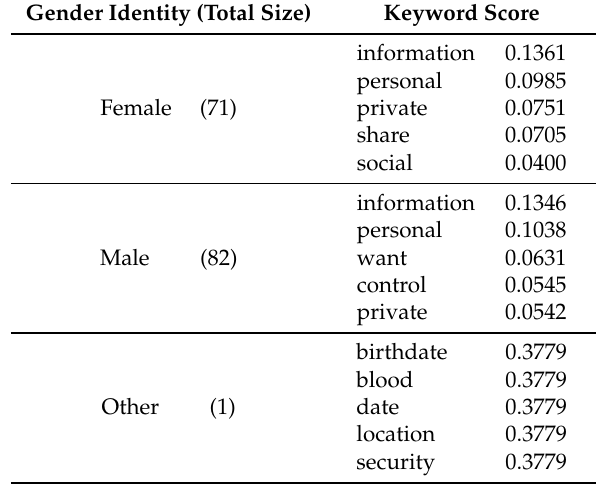
Table 4. Top five terms used to define privacy using average TF-IDF scores for each by gender demographic.